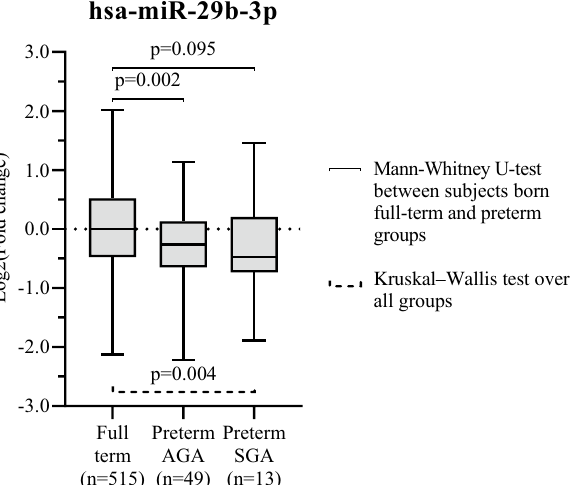
Figure 1. Blood levels of hsa-miR-29b-3p in subjects born preterm in comparison to those born full term. Blood levels of hsa-miR-29b-3p of subjects born preterm and either appropriate birth weight for gestational age (AGA) or small birth weight for gestational age (SGA) described by the Log2(fold changes) in comparison to subjects born full-term. MicroRNA-29b-3p expression was detected in 551 participants with birth weight and birth status